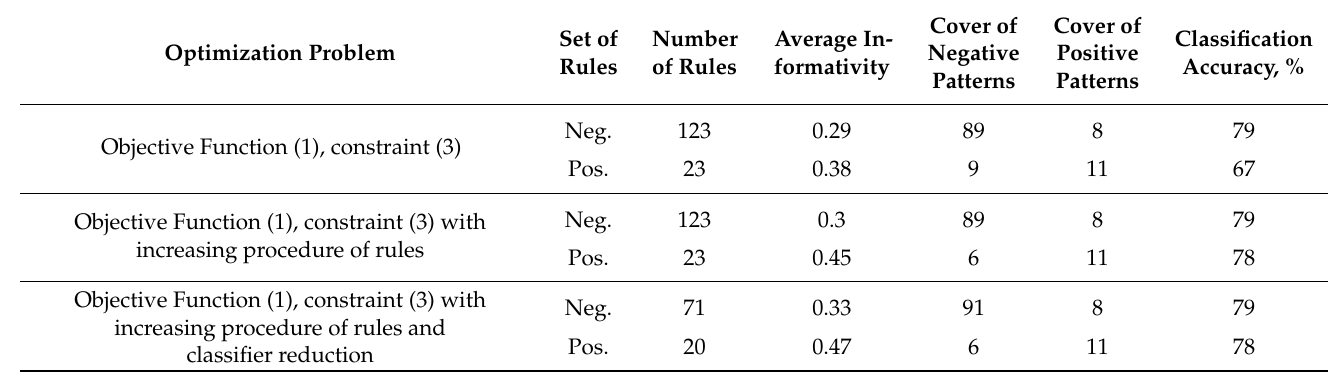
Table 6. Experimental study of the classifier reduction procedure for the problem of predicting the outcome of a patient’s disease with